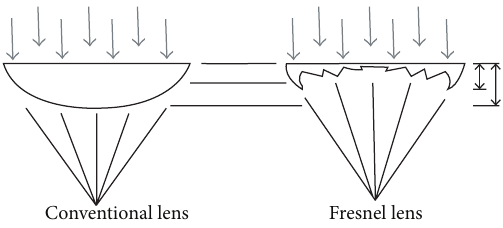
Figure 1: Conventional lens and Fresnel lens